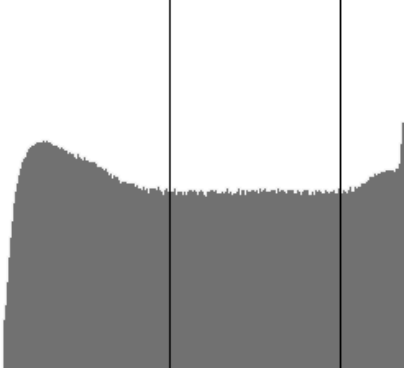
Figure 7. Logarithm of digital number histogram used for thresholding and initial threshold placement (relative y-axis scaling of image digital numbers).